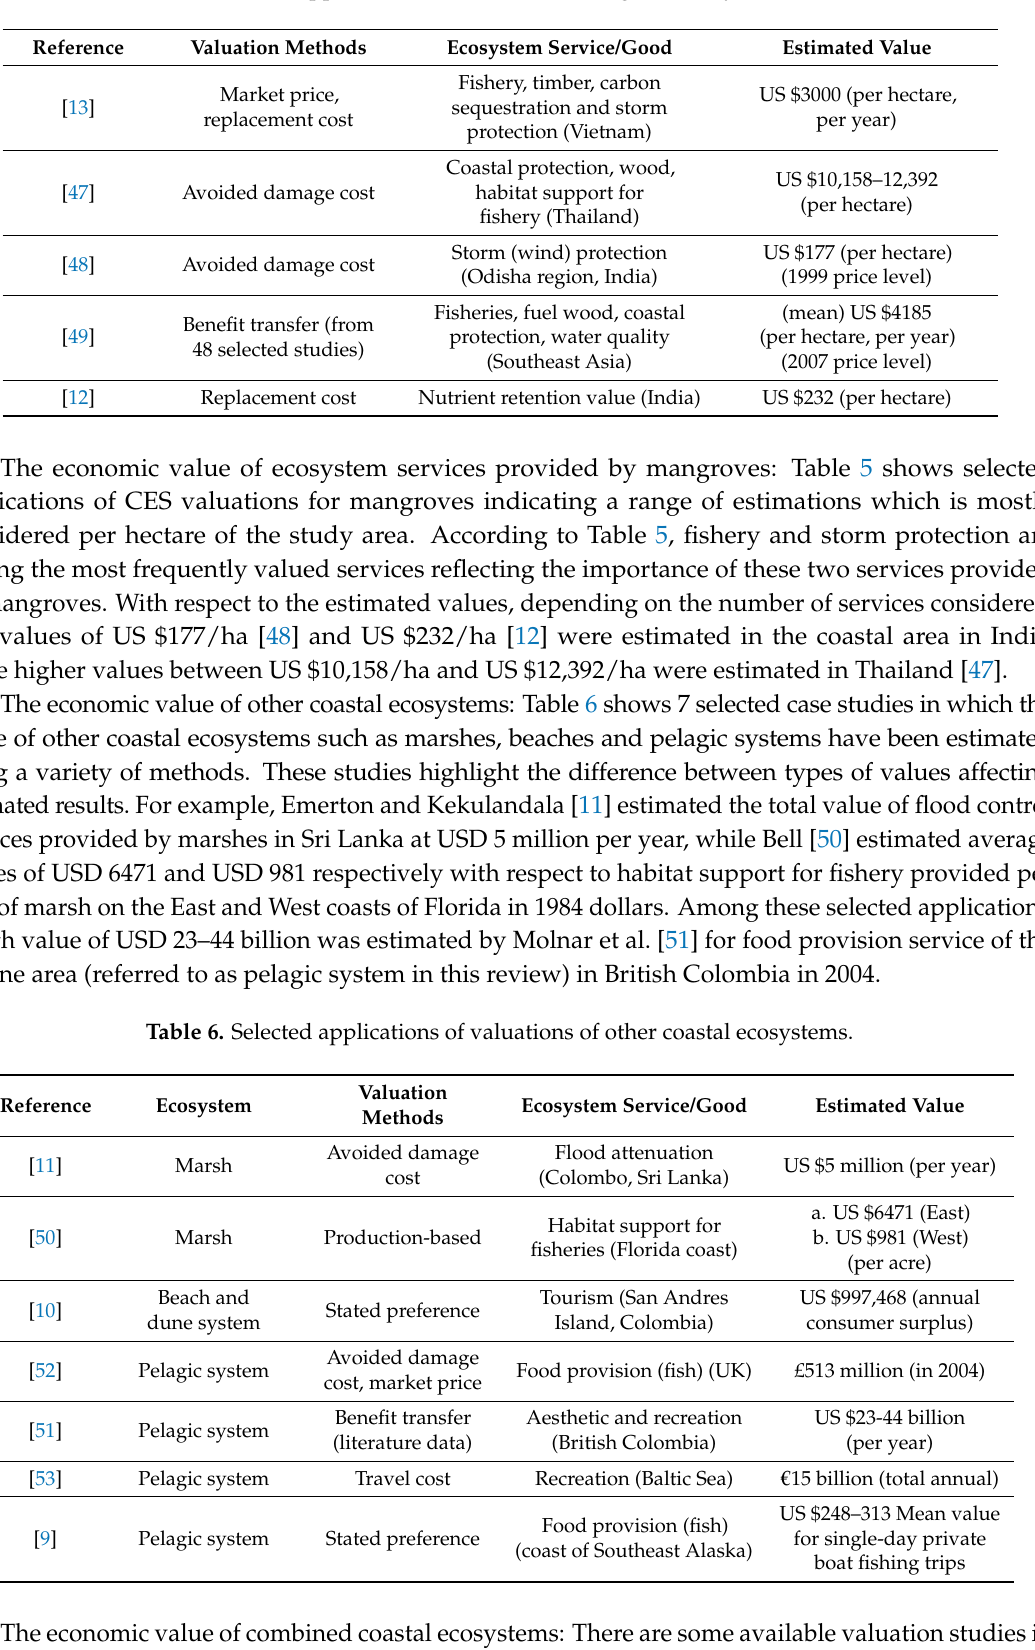
Table 5. Selected applications of valuation of mangrove ecosystem services.